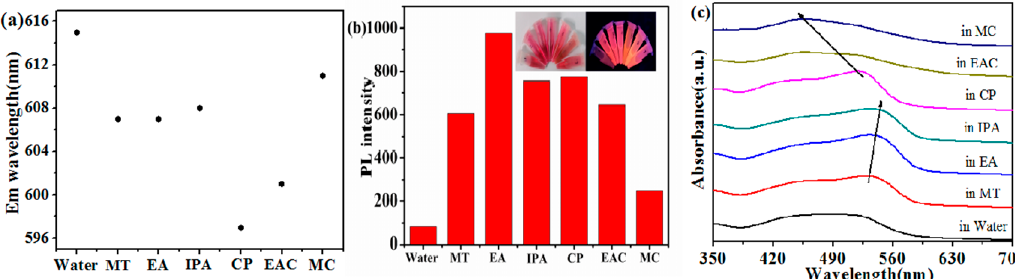
Figure 3. ( a ) Plot of the emission wavelengths of R-CDs dispersed in different polar solvents. ( b ) Bar graph of the fluorescence intensity of R-CDs dispersed in different polar solvents; insets are photographs under 365 nm UV-light (from left to right, water, MT, EA, IPA, CP, EAC, MC). ( c ) UV-vis spectra of R-CDs dispersed in different polar solvents.